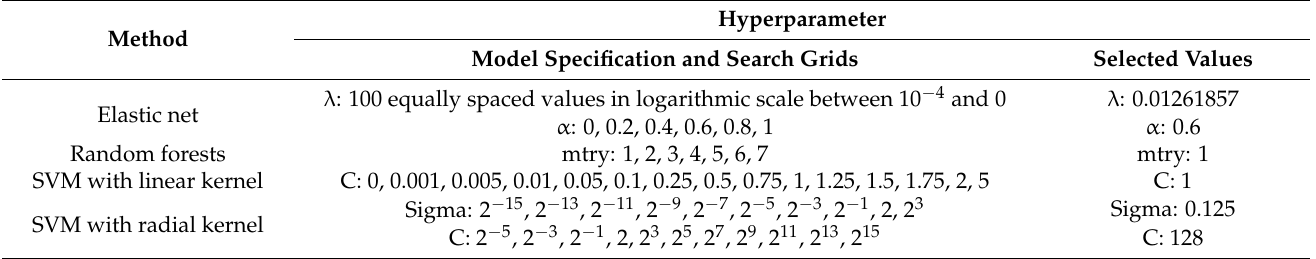
Figure 2. Receiver operating characteristic curves for predictive performance of the elastic net (ENET), logistic regression (LR), random forest (RF), and support vector machine radial (SVM_R) models. Table 4. Machine learning model specifics.